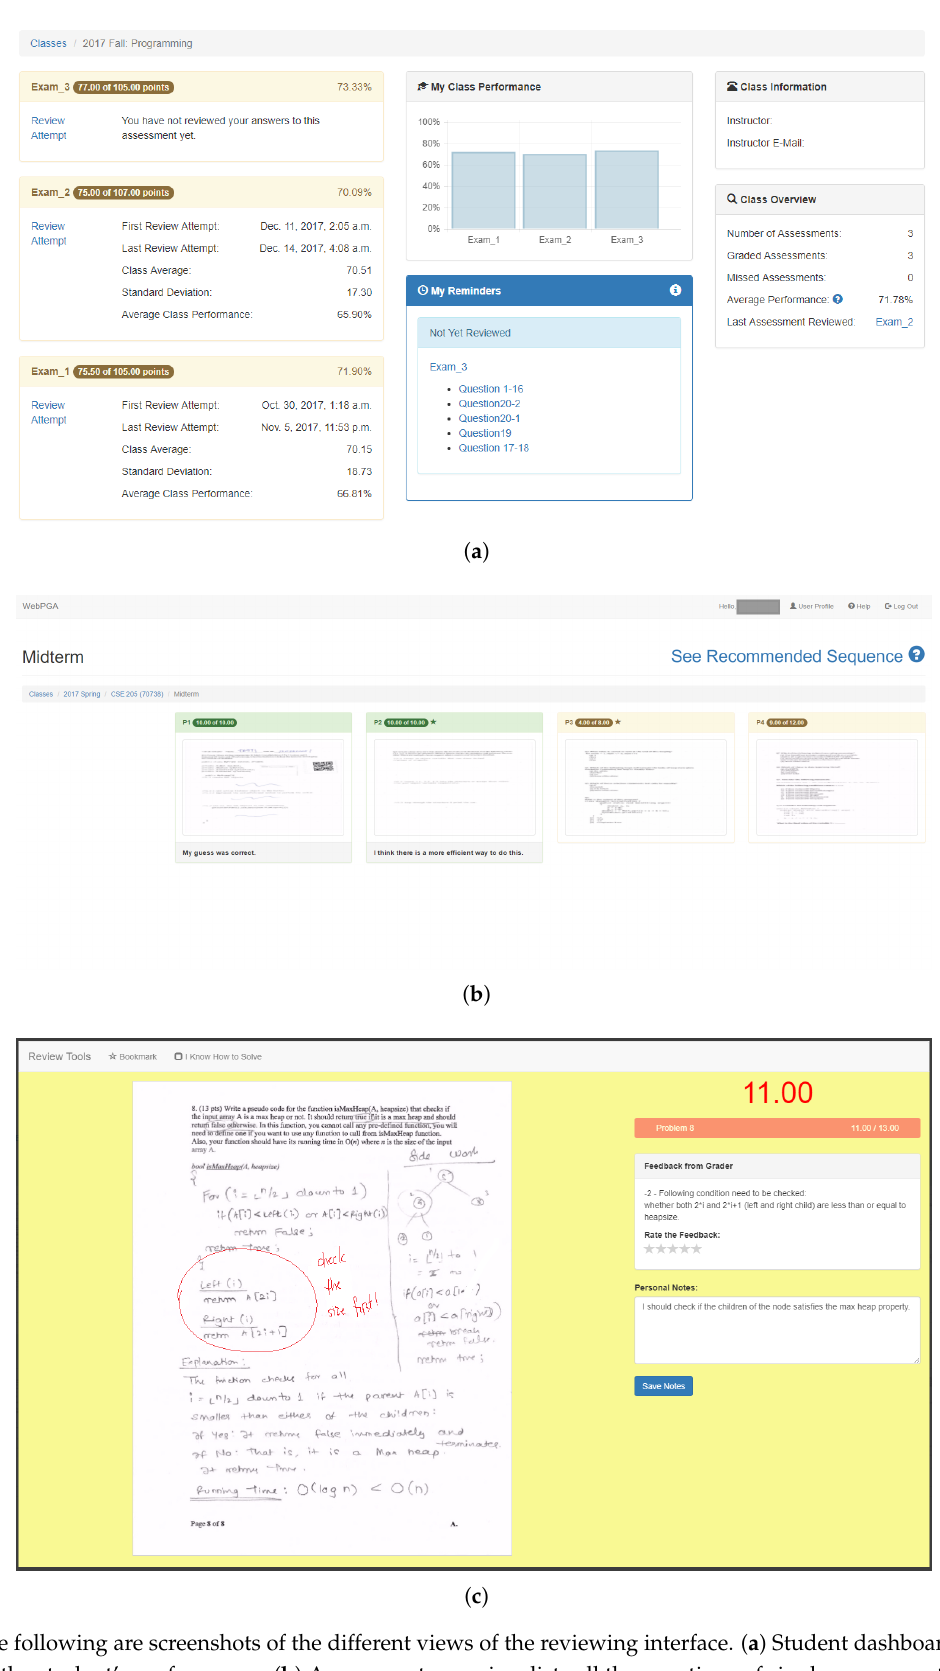
Figure 2. The following are screenshots of the different views of the reviewing interface. ( a ) Student dashboard provides an overview of the student’s performance. ( b ) Assessment overview lists all the questions of single assessment. ( c ) Question overview provides a detailed view of how a question was